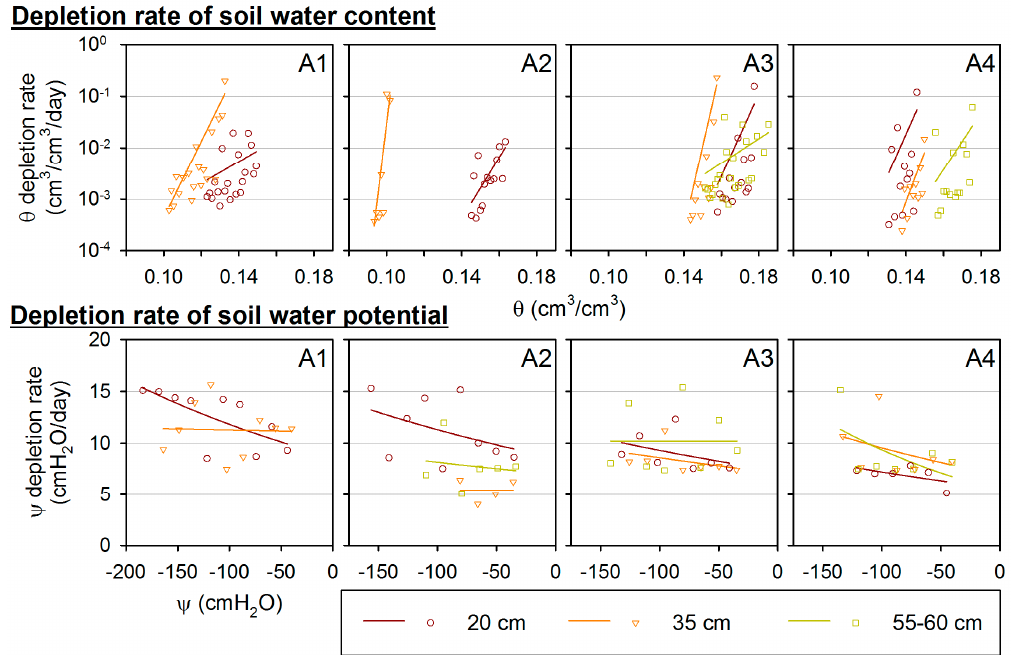
Figure 10. Instantaneous depletion rates of soil water content ( θ ) and soil water potential ( ψ ) against the values of θ and ψ at each point on measurement lines A1–A4 during the drying period from 31 July to 15 August 2013. An exponential trend line is fitted to the data at each measurement depth.